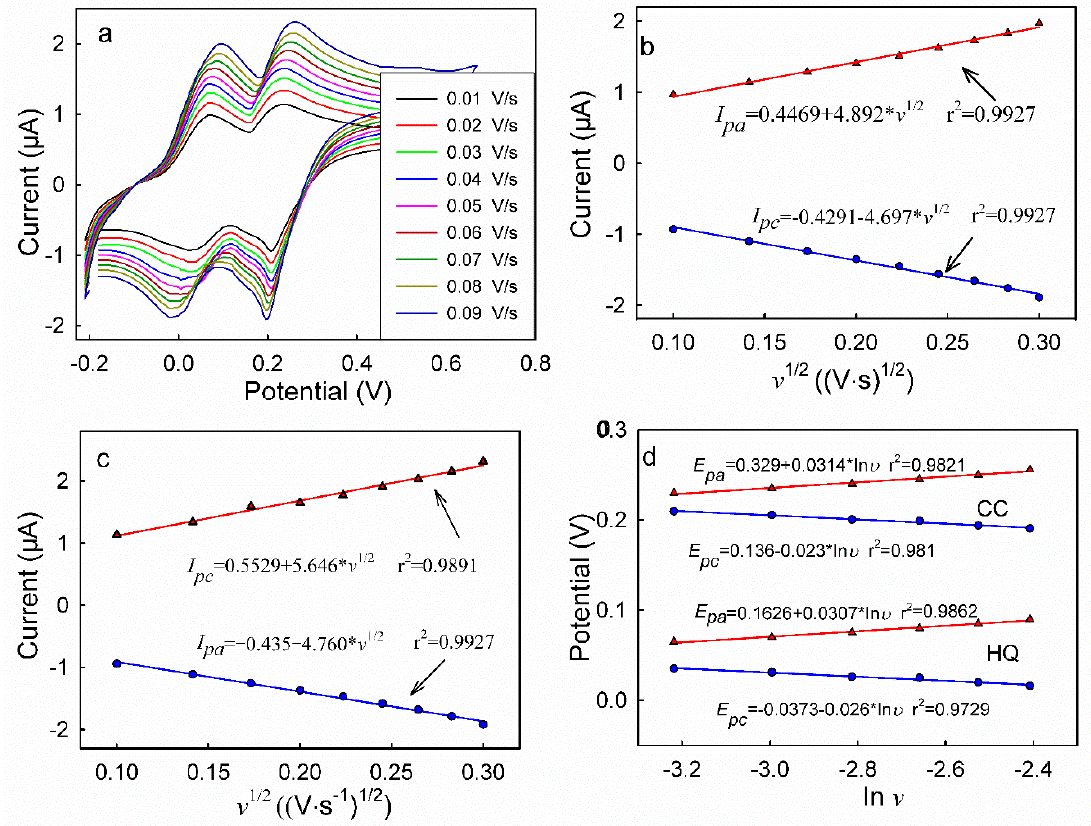
Figure 6. ( a ) The CV curves of HQ and CC on the PGIL–TiO 2 /Au electrode at different scan rates (0.01, 0.02, 0.03, 0.04, 0.05, 0.06, 0.07, 0.08, and 0.09 V/s). ( b ) The relationship between the redox peak current ( I p ) of HQ and scan rates ( v ). ( c ) The relationship between redox peak current ( I p ) of CC and scan rates ( v ). ( d ) The relationship between E p and scan rates ( v ).